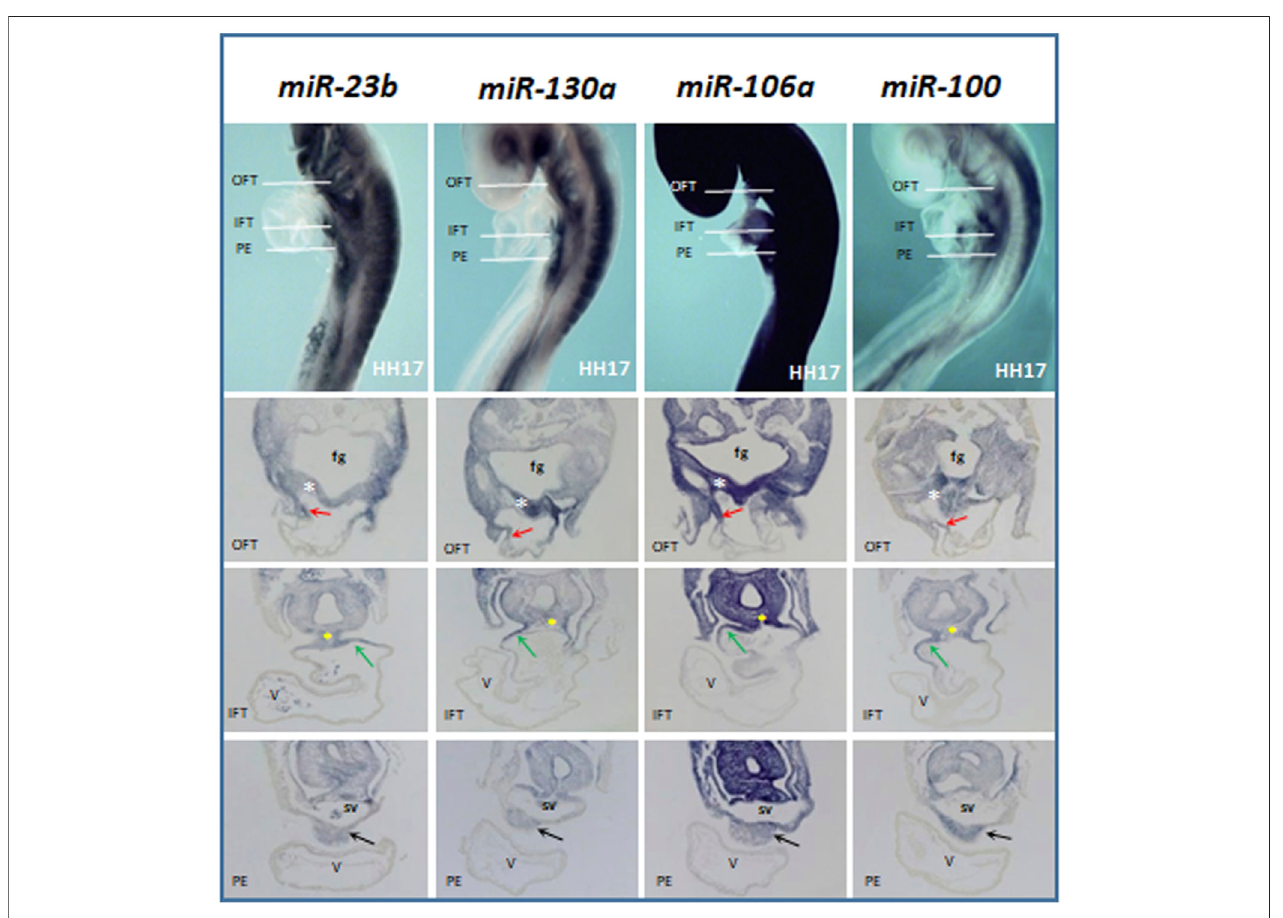
FIGURE 2 | Comparative whole-mount ISH analysis of miR-23b, miR-130a, miR-106a, and miR-100 expression pro fi les at stage HH17. The transverse section levels are indicated with white lines: OFT, out fl ow tract; IFT, in fl ow tract, and PE, proepicardium. Note their expressions in the lateral – dorsal wall of the OFT (red arrow), foregut (fg), dorsal wall of the IFT (green arrow), dorsal mesocardium (yellow asterisk), and proepicardium (black arrow). White asterisk, pharyngeal mesoderm; V, ventricle; sv, sinus venosus .